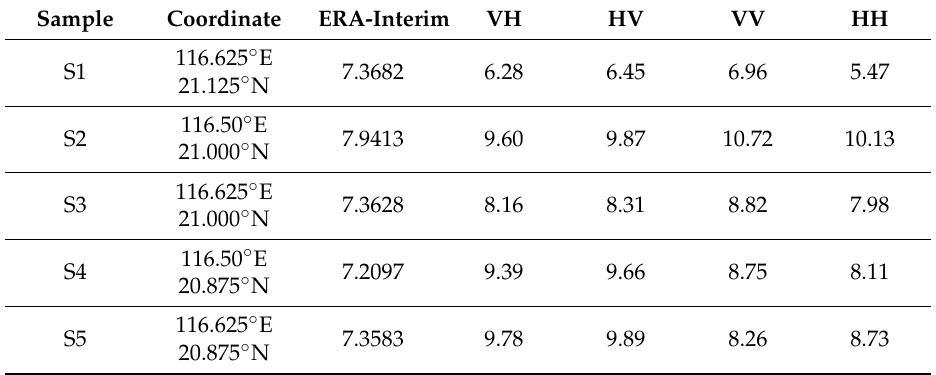
Figure 5. C-band ( a ) VH- and ( c ) HV-polarized SAR images in the South China Sea waters from RADARSAT-2 fine quad-polarization mode SLC SAR data acquired on 27 August 2012, at 10:25:24 UTC (grayscale color bar denoted NRCS). OSWS retrieved from ( b ) VH- and ( d ) HV-C2PO model. Symbol ‘+’ denotes winds grid cells from ERA-Interim data. RADARSAT-2 Data and Product MacDonald, Detweiler and Associates Ltd., All Rights Reserved. Table 1. OSWSs retrieved from the RS-2 fine quad-polarized mode SAR images compared with corresponding wind acquired from ERA-Interim daily (in units of m/s).